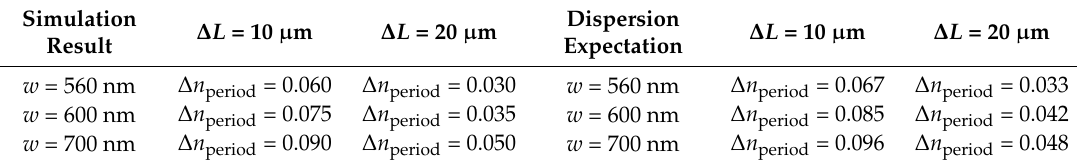
Figure 3. The output power versus refractive index for MZIs with different waveguide widths and optical path length differences. ( a ) w = 600 nm, Δ L = 10 μ m; ( b ) w = 600 nm, Δ L = 20 μ m; ( c ) w = 700 nm, Δ L = 10 μ m; ( d ) w = 700 nm, Δ L = 20 μ m; ( e ) w = 560 nm, Δ L = 5 μ m. Insets show the electric field images near an output port in the x-y plane at the corresponding local maximum and minimum points. Each image is normalized by its maximum amplitude. Table 1. Oscillation periods of the refractive index in the plasmonic channel waveguide MZI, obtained by FDTD simulation (left) and by calculation from the dispersion curves shown in the Figure 2 (right). The oscillation period indicates the index change, which modulates the output power of the MZI sensor, with one cycle from minimum to minimum. A smaller oscillation period means a more sensitive MZI index sensor. Output power graphs for the MZIs with w = 560 nm and Δ L = 10 μ m or 20 μ m are not shown. For the MZI with w = 560 nm and Δ L = 5 μ m, Δ n period = 0.14 is estimated from the simulation of Figure 3e and Δ n period = 0.13 is calculated from the dispersion in Figure 2.